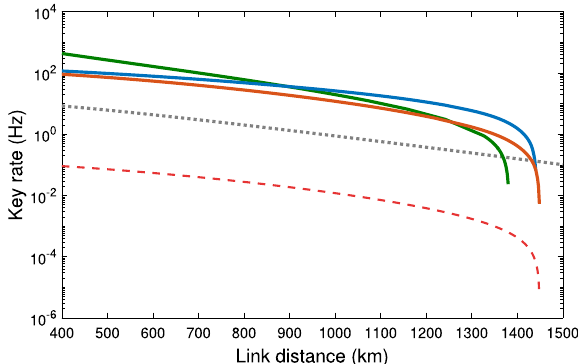
Fig. 4 Comparison of MA-QKD schemes with ent-QKD (no memory) protocol. Grey dotted: ent-QKD ( R s = 20 MHz); blue: uplink con fi guration with storage time 5 ms; solid (dotted) red: downlink con fi guration, with N = 1000 (single) temporal modes with storage time 7.5 s; green: downlink with N = 1000 temporal modes and m = 100 memory pairs with storage time 100